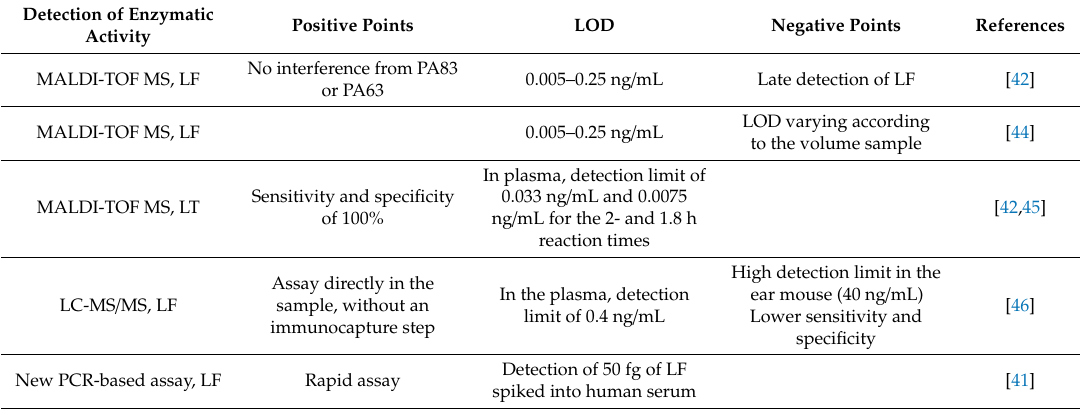
Table 2. Comparison of assays using enzymatic activity for the detection of anthrax toxins. Detection of Enzymatic